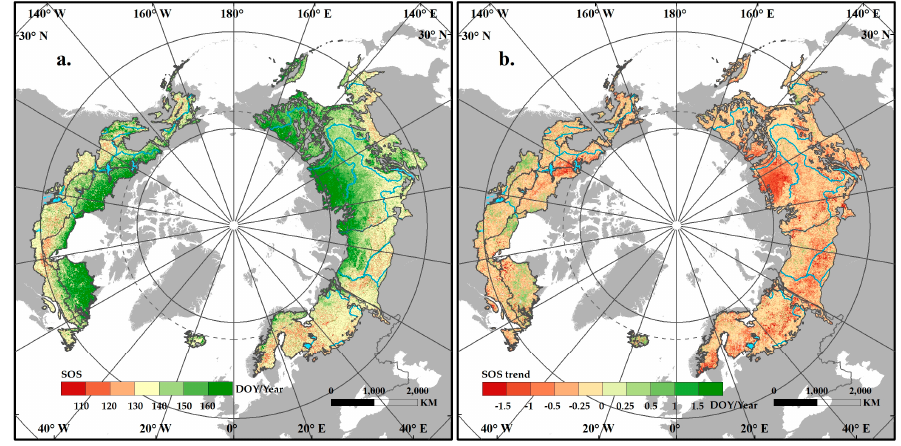
Figure 5. Spatial patterns of the SOS dates ( a ) and their trends ( b ) for the boreal forest from 2001 to